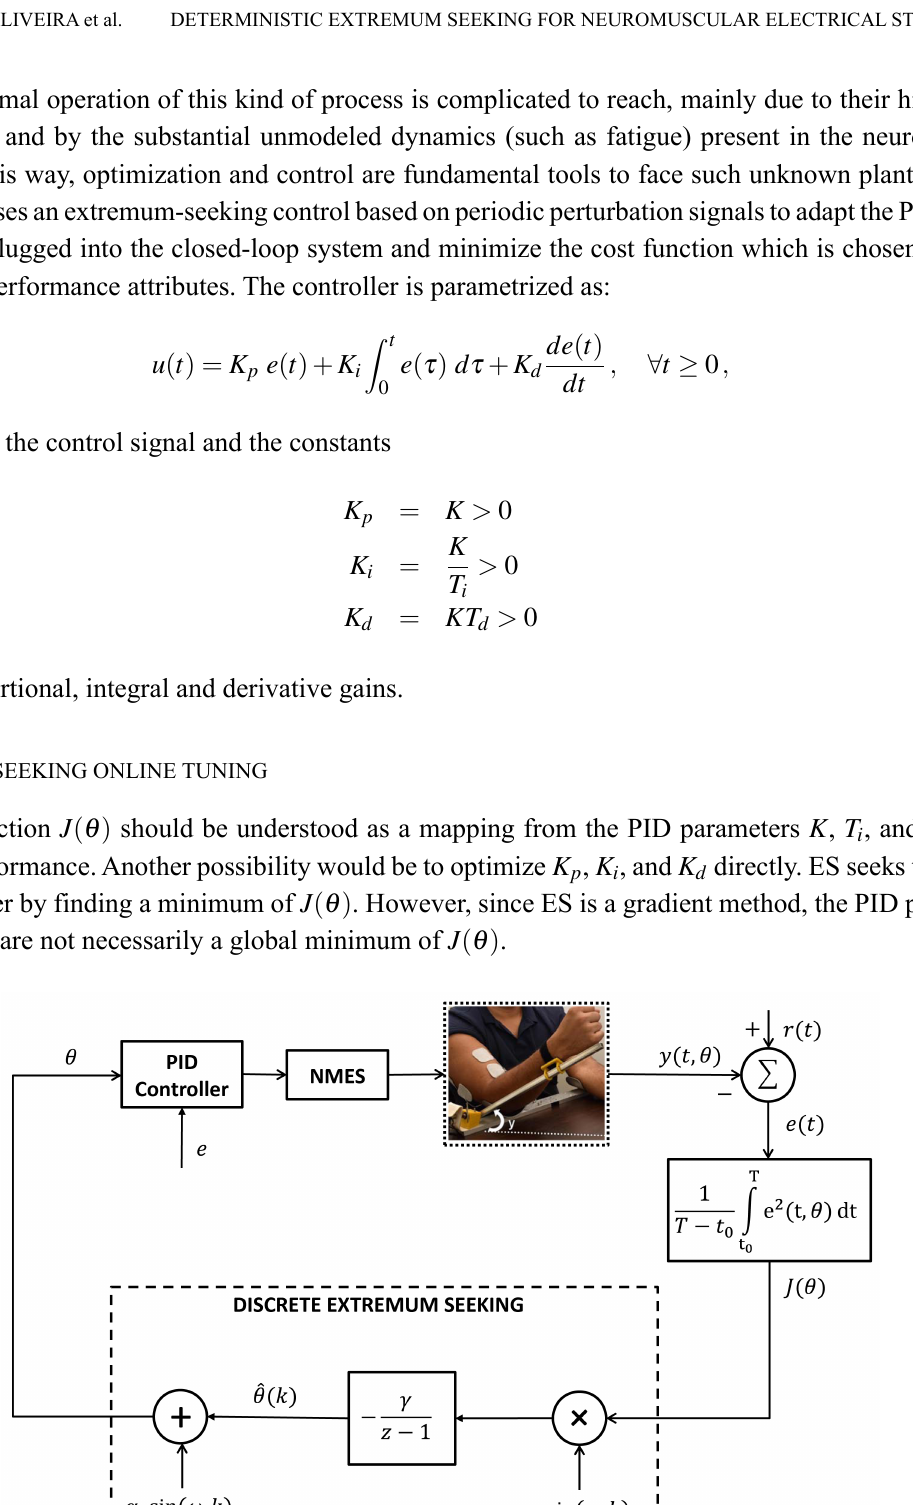
An Acad Bras Cienc (2019) 91(Suppl.